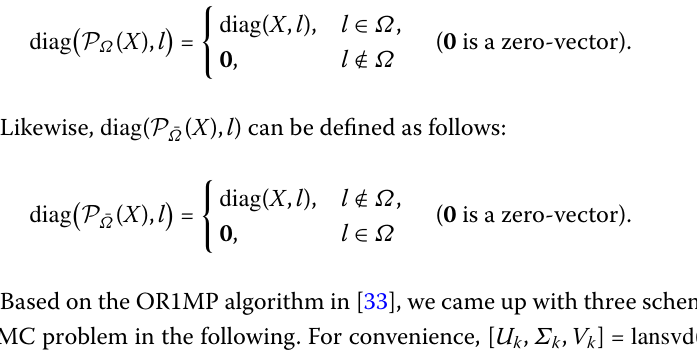
Algorithm 2.1 ([12] (The MOR1MP algorithm for the TMC problem)) Given a sam- pled set Ω and the sampled entries P Ω ( D ) = Y Ω , ε = 10 –3 , maxiter. Given also the initial Toeplitz matrix X 0 = 0, k :=